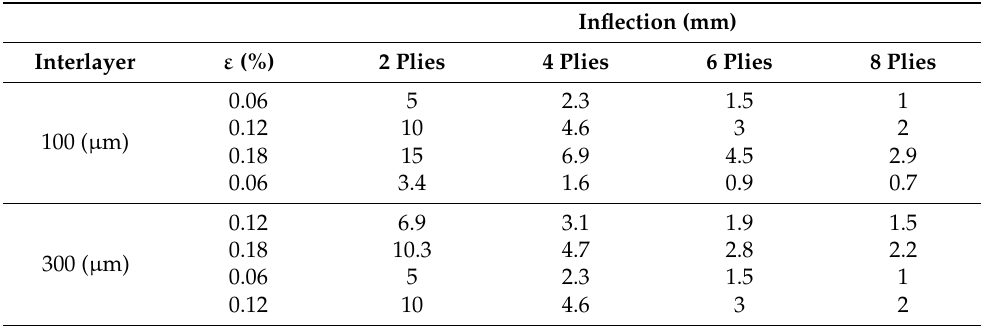
Table 2. Imposed displacement of the free end of SMPC